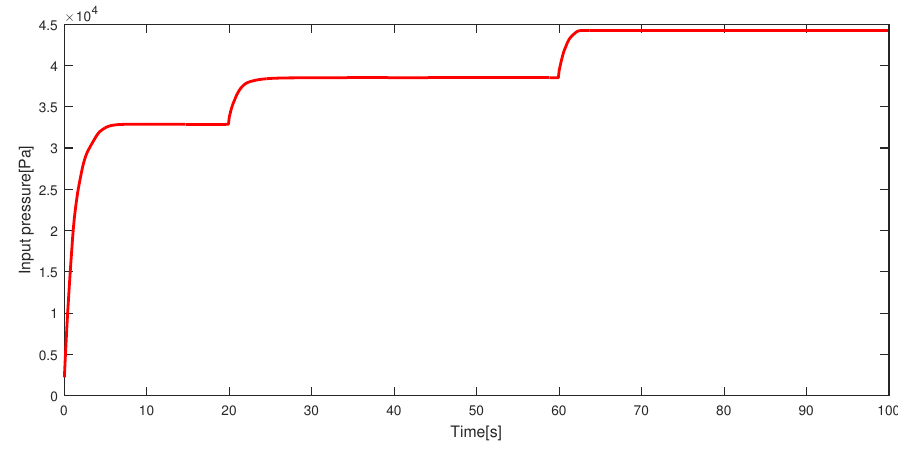
Figure 17. Plant